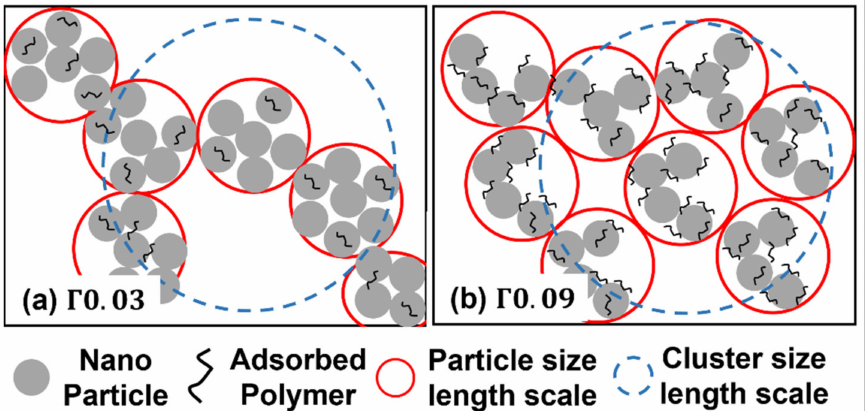
Figure 8. Schematics of SiNP distribution in PVA matrix at t = 55 min. ( a ) Γ 0.03 and ( b ) Γ 0.09. Red circles: particle length scale corresponding to high q range of SAXS spectra. Blue dashed circles: cluster length scale corresponding to low q range of SAXS